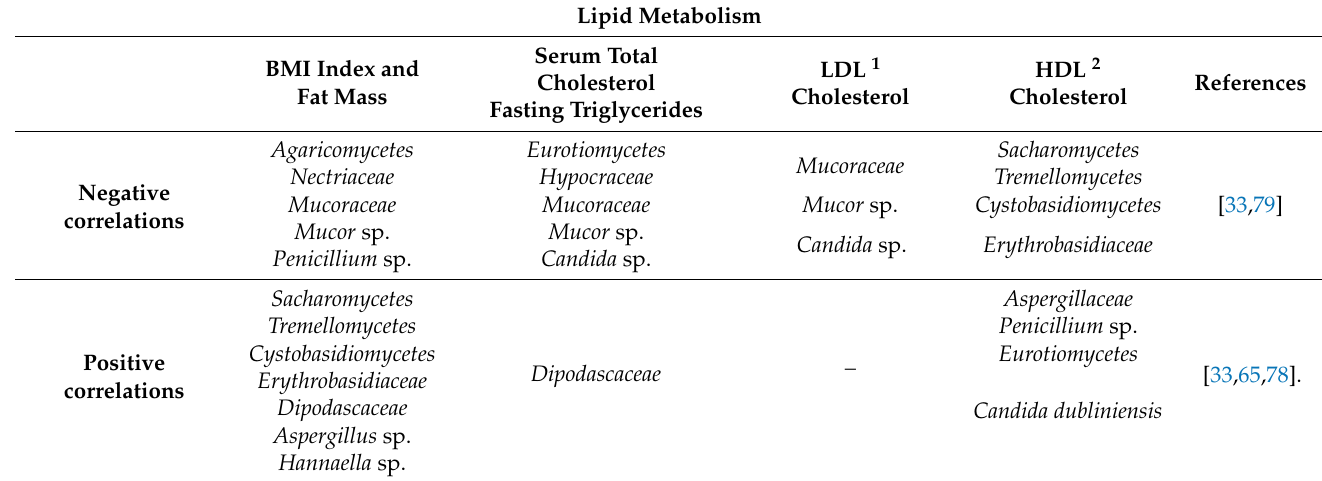
Table 3. The list of negative and positive correlations between lipid metabolism indices and gut mycobiome taxa.